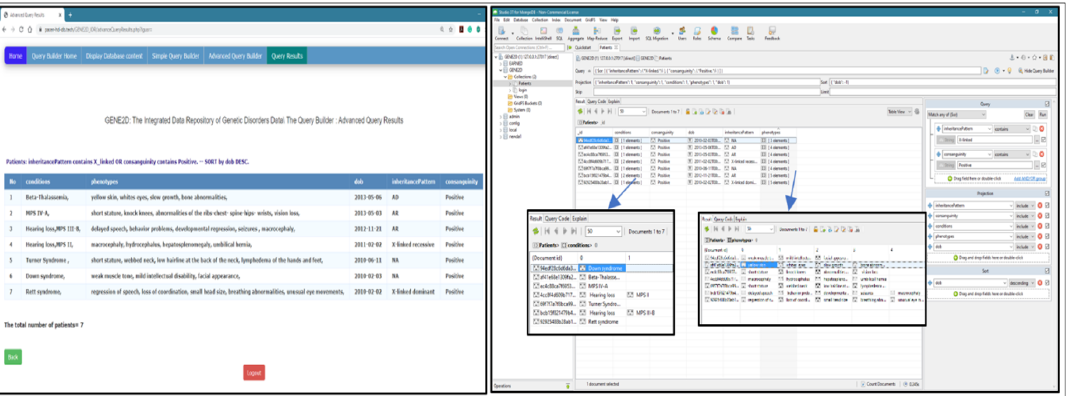
Figure 13. Testing advanced query with the logical operator (OR).